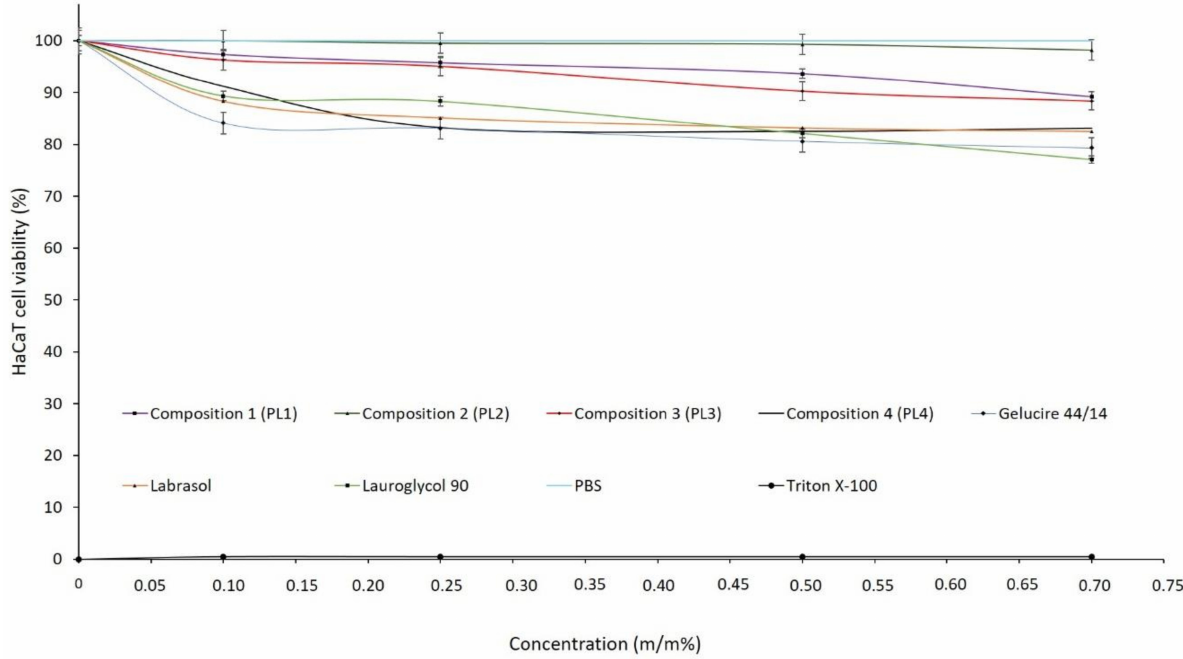
Figure 5. Toxic effects of formulated blends and their components on HaCaT cell viability. Each data point represents the mean ± SD, n = 10. The Triton-X-treated group was evaluated as the positive control; phosphate-buffered solution (PBS) was used as the negative control.